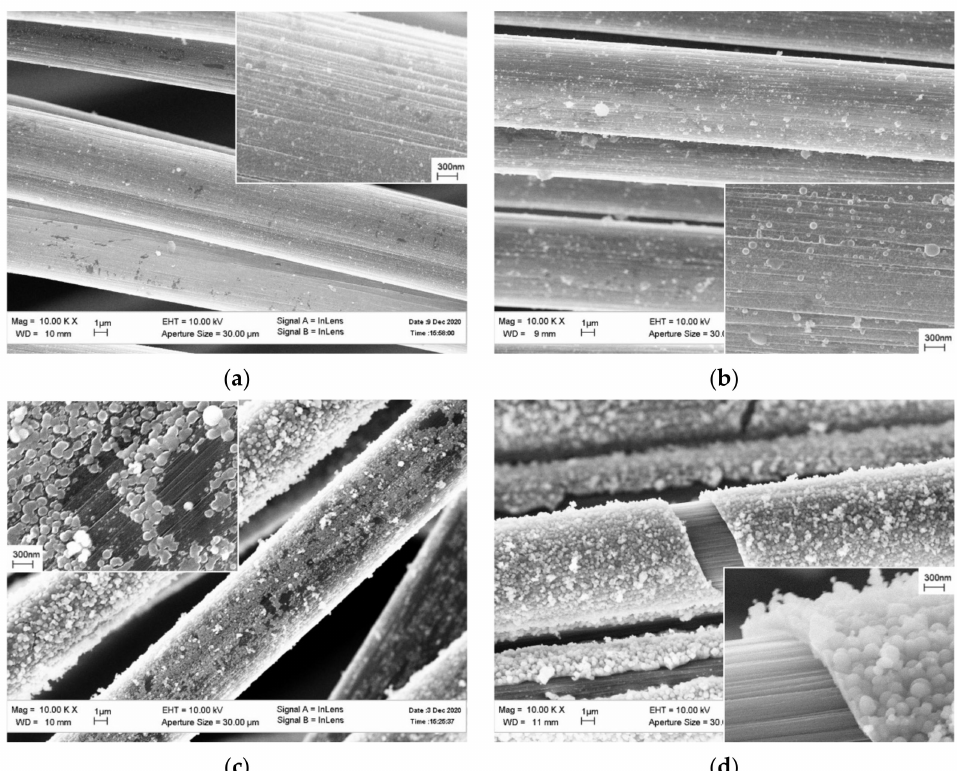
Figure 13. Surface of the coated carbon fiber at different deposition times: ( a ) 0.01 min, ( b ) 0.06 min, ( c ) 0.1 min, ( d ) 0.5 min.